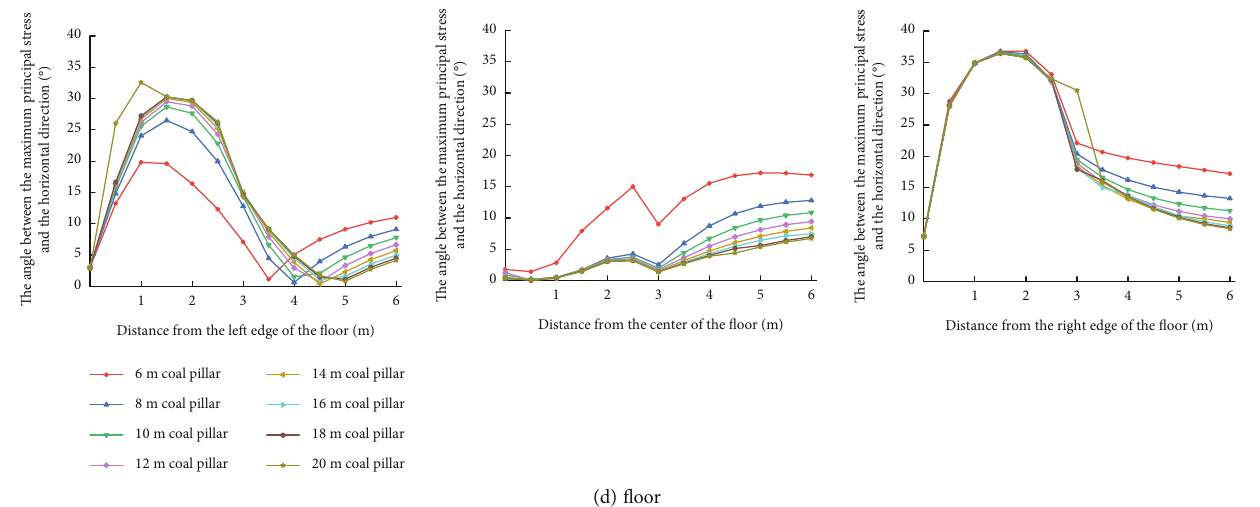
Figure 5: Variation curve of maximum principal stress direction of surrounding rock. Table 3: The maximum principal stress de fl ection law of surrounding rock in roadway excavation. Surrounding rock location Roof Coal pillar Floor Coal